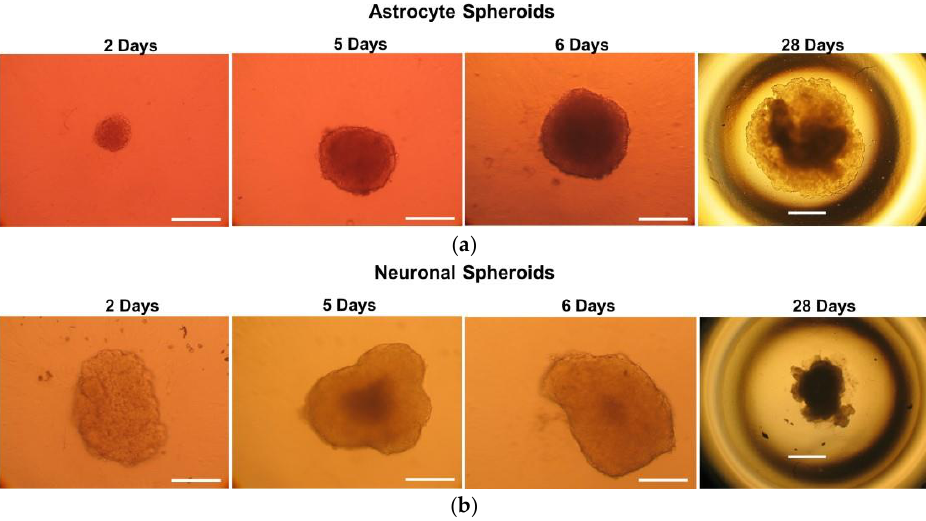
Figure 1. Microscopy images of astrocyte and neuronal spheroids: ( a ) Representative images of D384 spheroids by light field microscopy grown at the indicated time points. Scale bars: 100 μm for 2, 5 and 6 days; and 600 μm for 30 days, respectively; ( b ) Representative images of SH-SY5Y spheroids by light field microscopy grown at the indicated time points. Scale bars: 100 μm for 2, 5 and 6 days; and 600 μm for 30 days, respectively.